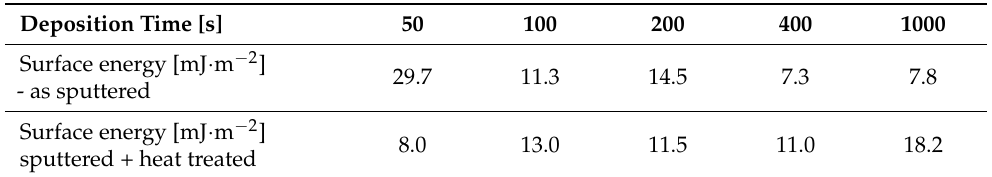
Table 1. Surface free energy of PDMS foils deposited with Ag and current 20 mA and the same set of samples which underwent heat treatment (285 °C, 1 h).